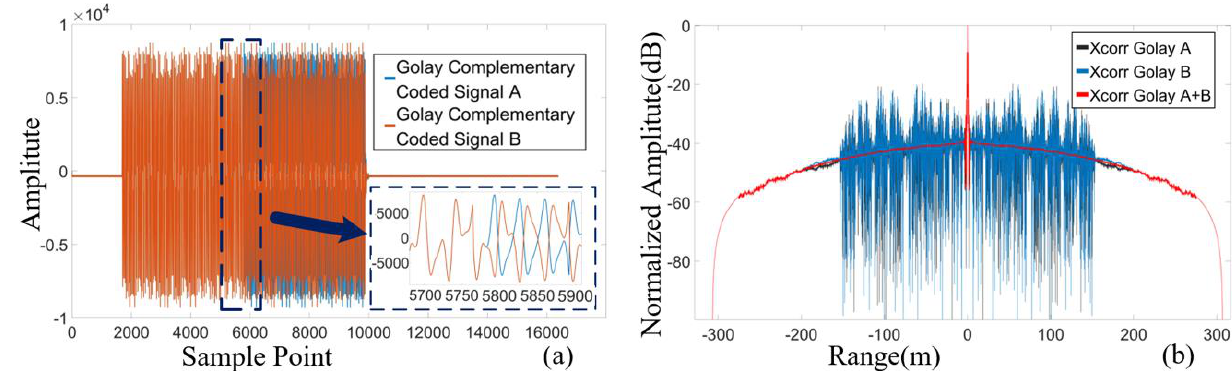
Figure 3. ( a ) The Golay complementary coded signal sampled by the receiver. ( b ) The autocorrelation result of Golay code A, Golay code B and the sum of both.